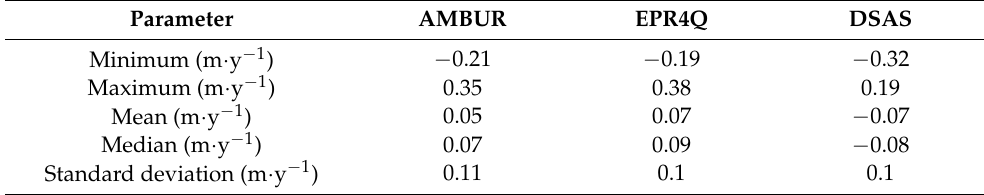
Table 5. Statistical parameters between the different methods applied to the Rockport shoreline analysis.